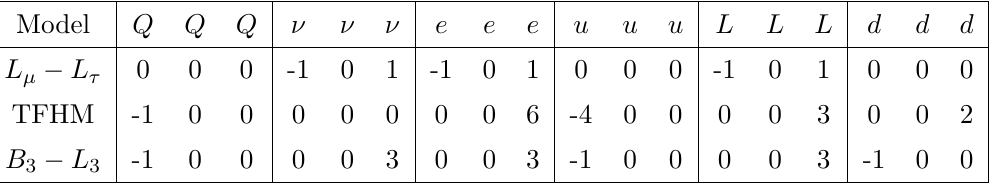
Table 4 . U(1) F charges as output by the program for some example solutions present in the literature. \TFHM" refers to the Third Family Hypercharge Model and B 3 (cid:0) L 3 to third family baryon minus lepton number. Note that the charges within a species are labelled in increasing order from left to right and so the ordering does not re(cid:13)ect the family assignment. Also note that the charges are multiplied by a rational constant in each case in order to get the traditional U(1) F charge assignments: -1/6 for the TFHM and -1/3 for B 3 (cid:0) L 3